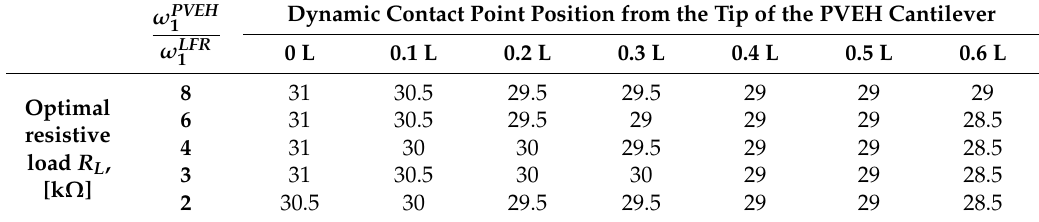
= ( a ) 8; ( b ) 6; ( c ) 4; ( d ) 3; ( e ) 2. / ω LFR 1 1